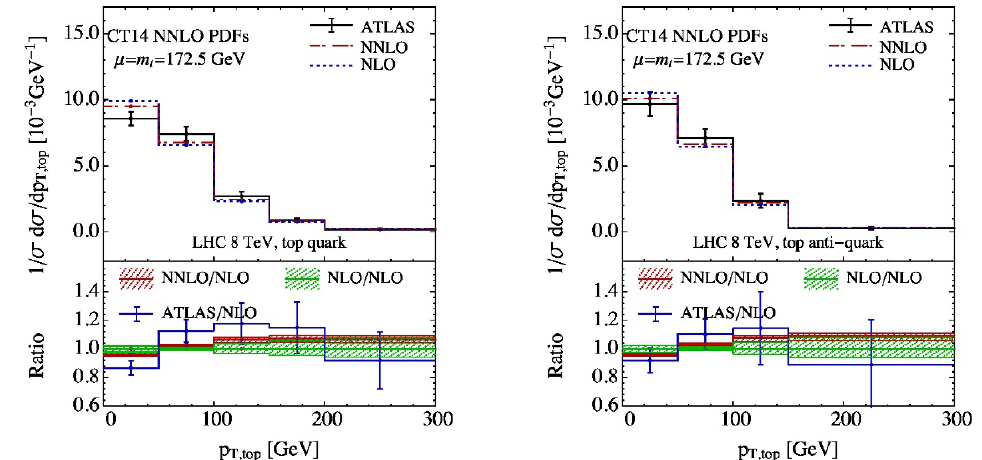
Figure 23 . Predicted transverse momentum distribution of the top (anti-)quark from t -channel single top-quark production at 8 TeV compared with the ATLAS data.